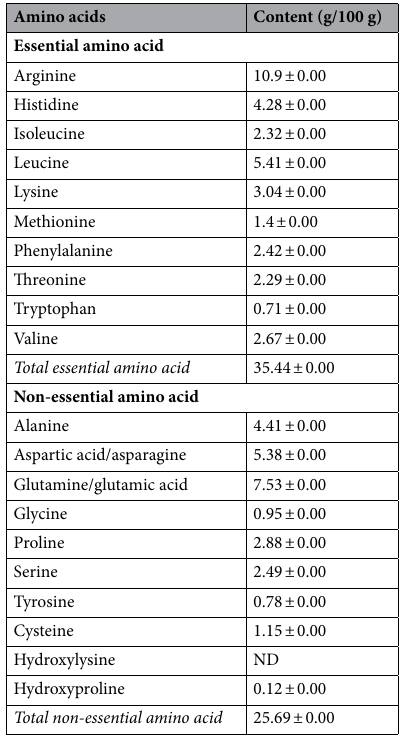
Table 4. Amino acid composition of protein extracted from Bombay by selected ultrasound-assisted process at 60% amplitude for 20 min. ND, not